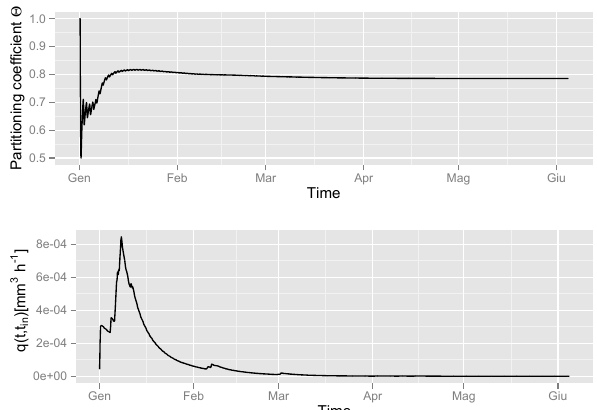
Figure 7. Variation of the partitioning coefficient in time, for a sin- gle injection time in January: after a timescale of 5 months its os- cillation became irrelevant and its value tended to its final value of 0.78.